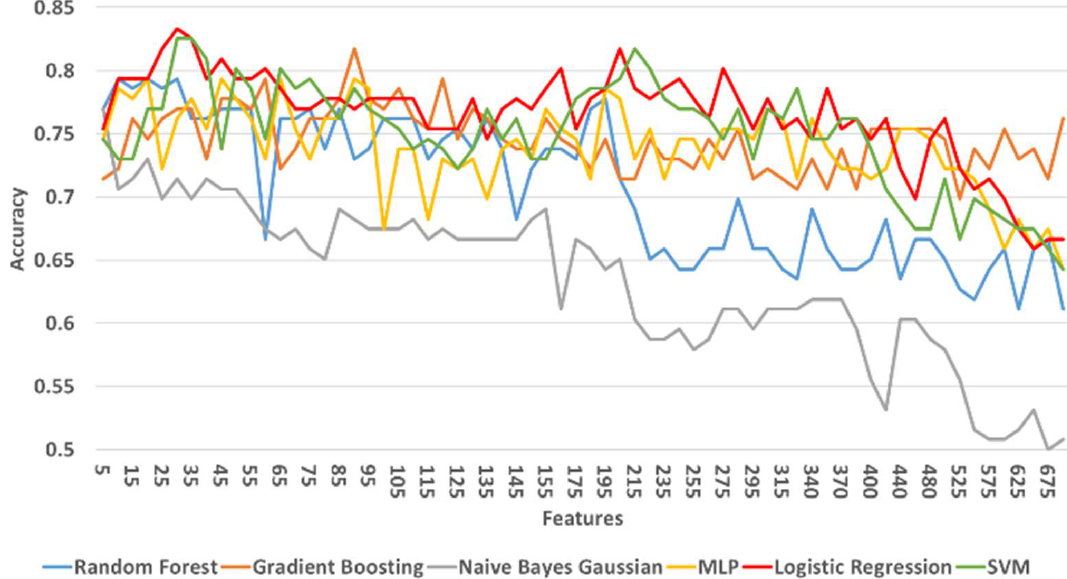
Figure 9. The accuracy of prediction models over test set for various number of features for the left and right legs combined. Results are shown with a step size of 5 (two features added at each step).